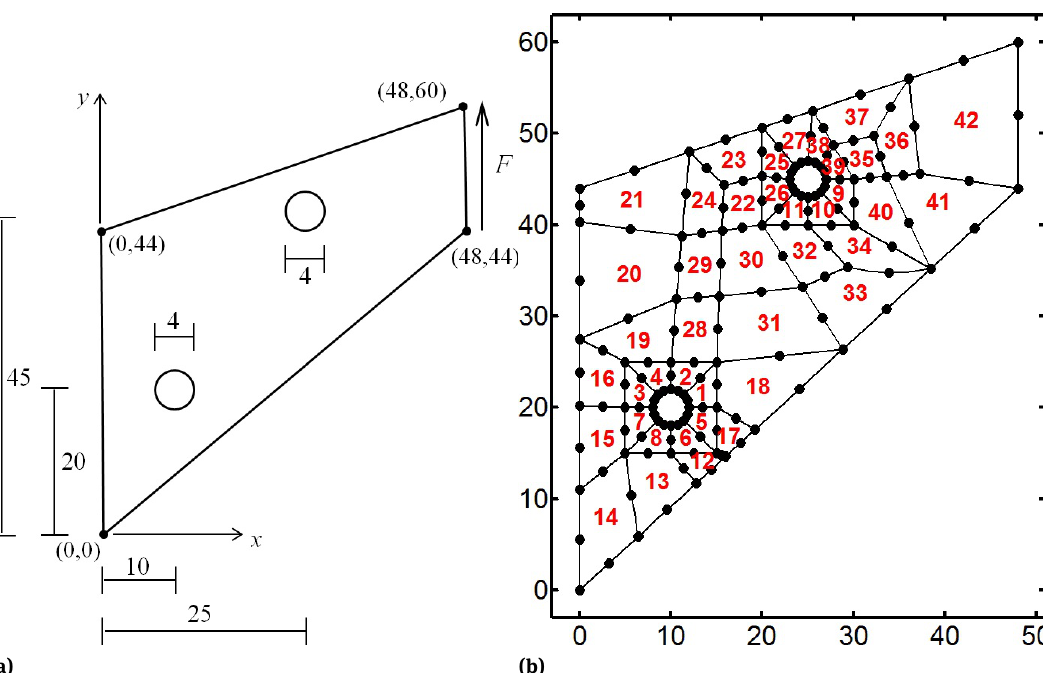
Figure 17: a) Geometry of the Cook’s beam with two eccentric holes (dimensions in meters [m]). b) SFEM mesh used in the computations.